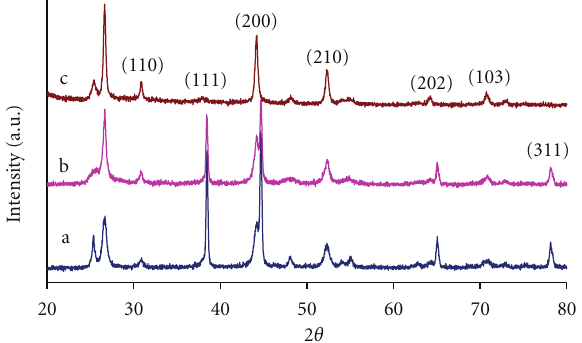
Figure 4: XRD analysis of STO calcined at (a) 500 ◦ C, (b) 550 ◦ C, and (c) 800 ◦